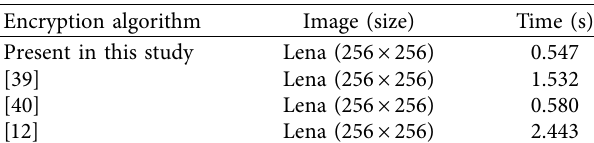
Table 6: Speed analysis